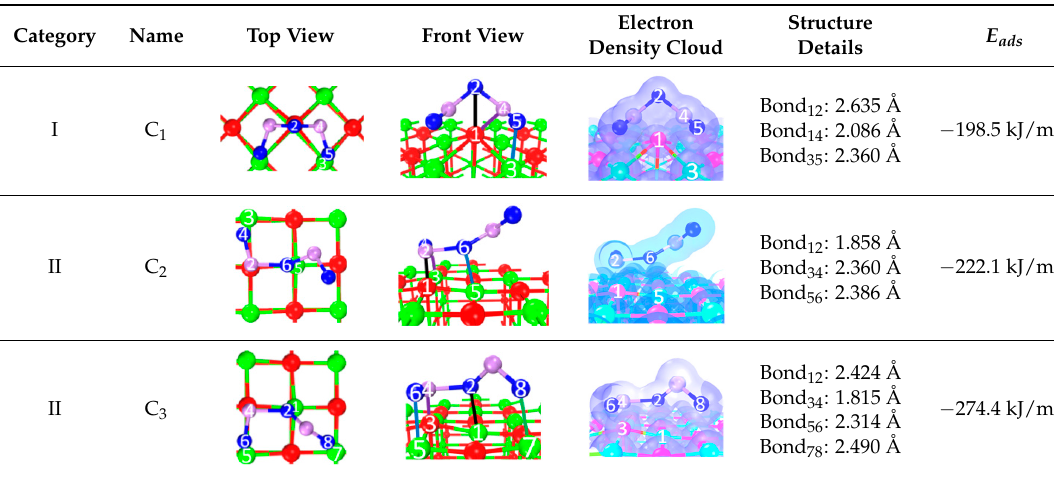
Table 3. Chemisorption structures, adsorption energy, electron density cloud and E ads.